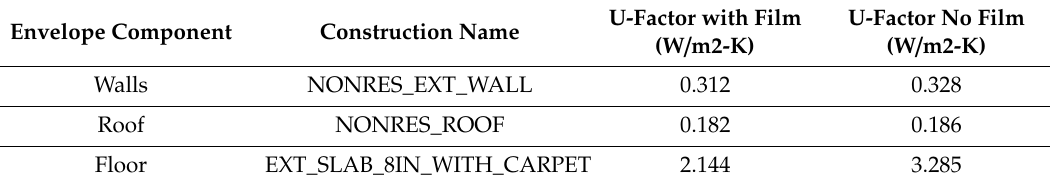
Table A3. Building envelope properties for New2016 vintage building in Chicago.